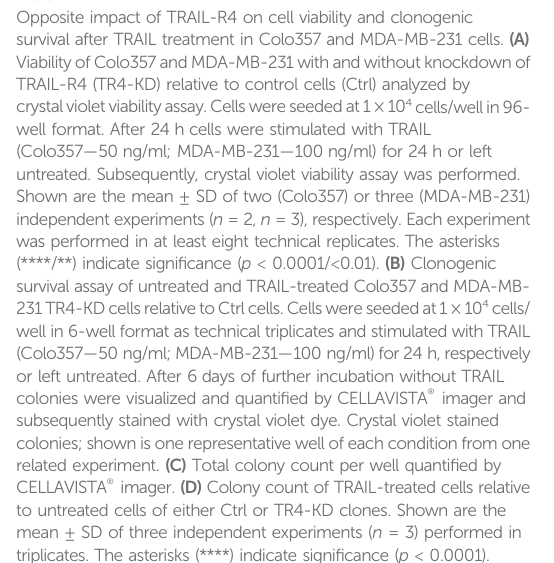
FIGURE 1 Establishment of Colo357 and MDA-MB-231 TRAIL-R4- knockdown cells. (A) Quantitative PCR showing the relative expression of TRAIL receptor 4 (TRAIL-R4) in Colo357 and MDA- MB-231 TRAIL-R4-knockdown clones (TR4-KD) normalized to control cells (Ctrl). Shown are the mean ± SD of three biological replicates ( n = 3). The asterisks (****) indicate signi fi cance ( p < 0.0001). (B) Western blot analysis of TRAIL-R4 expression from whole-cell lysates of Colo357 and MDA-MB- 231 Ctrl and TR4-KD cells. Detection of β -Actin served as a loading control. Representative picture from at least fi ve biological replicates.